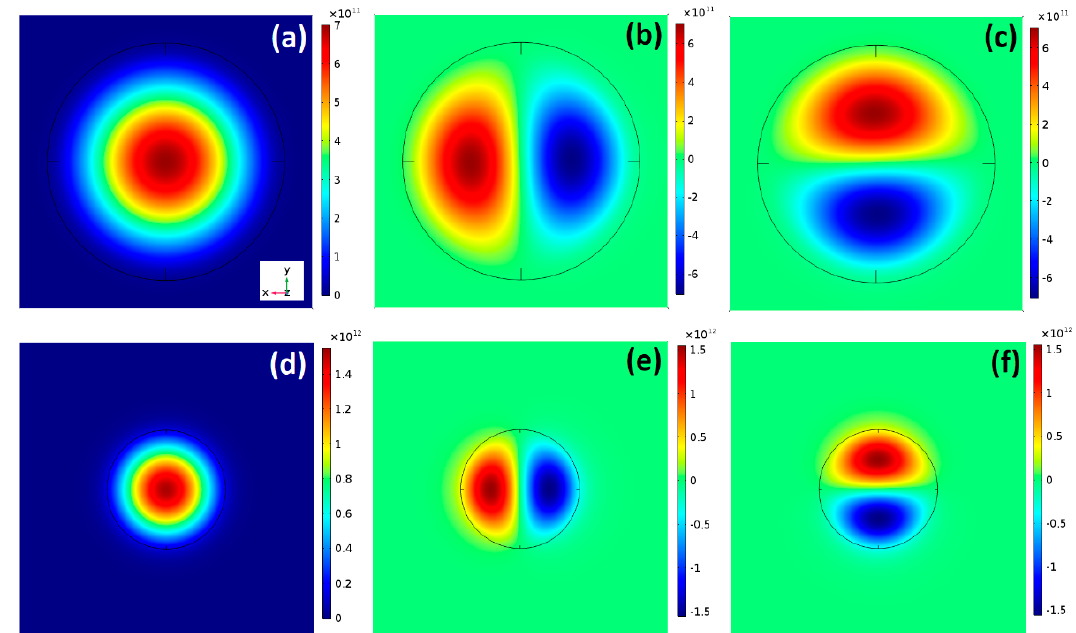
Figure 3. In plane-normalized s ( a , d ), p x ( b , e ) and p y ( c , f ) electron envelope wave function for a QD with diameter 40 nm and 20 nm respectively.